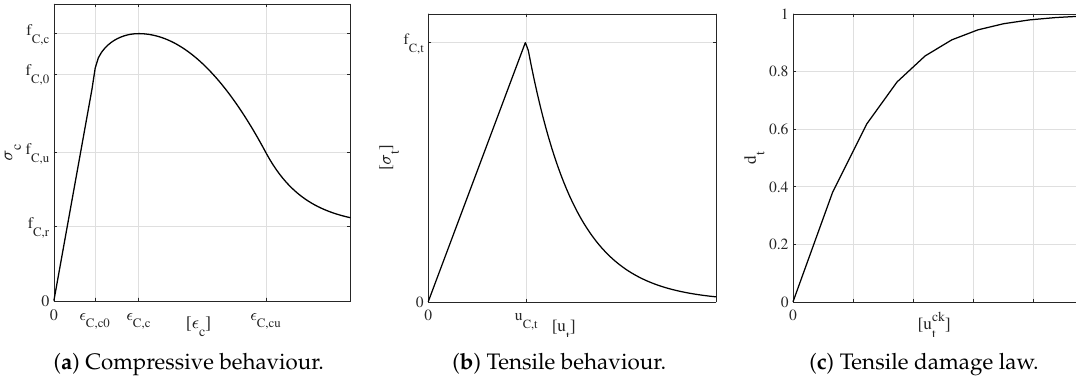
Figure 4. Constitutive model of the dam concrete.